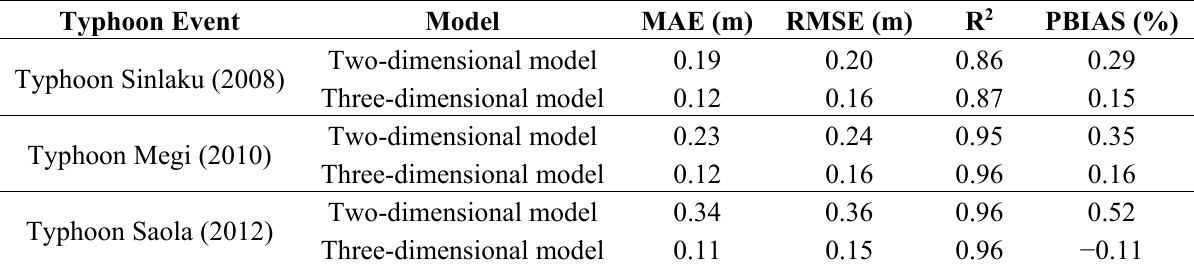
Table 2. Model performance for predicting water levels using two-dimensional and three-dimensional models at the Yuansnatze diversion weir for different typhoon